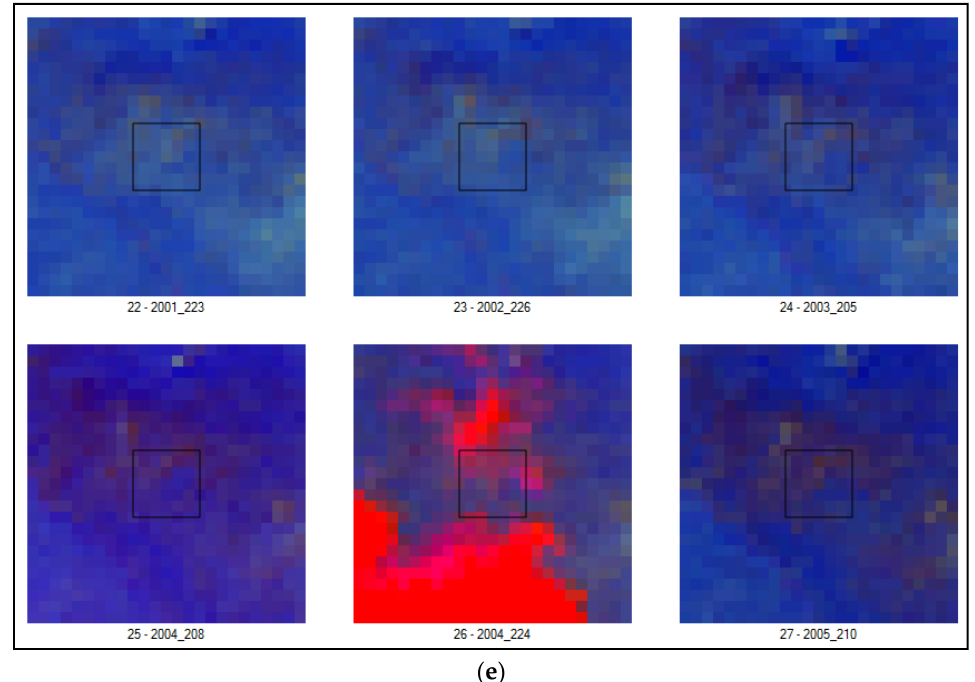
Figure A5. A 2003 Progressive Defoliation patch generated by LandTrendr at North Cascades National Park. ( a ) Photo collected during field validation. Photo credit: NPS/ Chris Lauver (2011). ( b ) Pre-disturbance 1998 aerial photo as viewed in Google Earth™. ( c ) Post-disturbance 2013 aerial photo as viewed in Google Earth™. ( d ) TimeSync spectral trajectory of thirty six pixels around patch centroid. ( e ) Part of the series of tasseled-cap image chips covering pre- and post-disturbance years as viewed in TimeSync. Bright red color in ( e ) the last image chip corresponds to clouds.